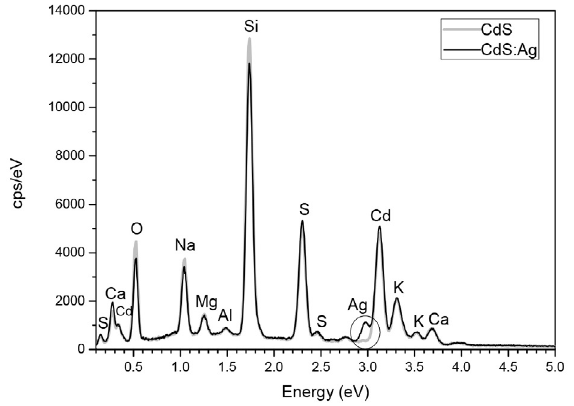
Figure 6. EDS measurements of CdS (gray solid line) and silver coated CdS (black solid line) thin films.